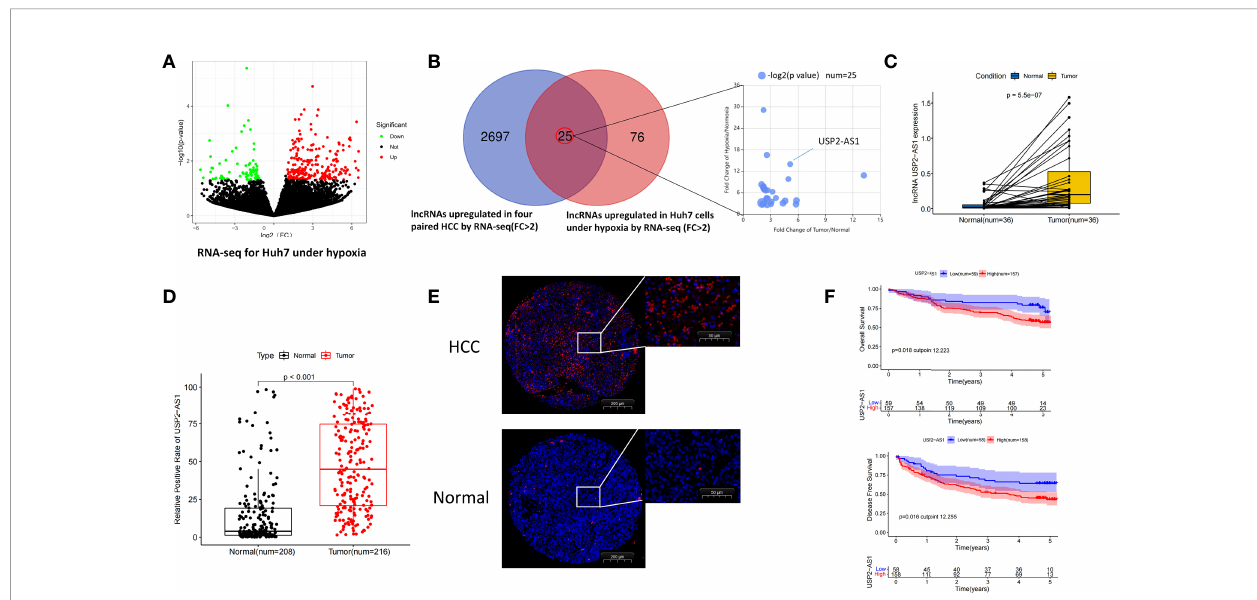
FIGURE 1 | USP2-AS1 is signi fi cantly up-regulated in hepatocellular carcinoma. (A) Molecules differentially expressed under normoxia and hypoxia in Huh7 cells identi fi ed by RNA-seq. (B) 25 intersection candidate genes obtained by hypoxia-treated Huh7 cells and HCC tissue sequencing. (C) The relative expression of USP2-AS1 in 36 pairs of HCC and adjacent non-tumor specimens by RT-qPCR. (D) Relative expression of USP2-AS1 in the HCC chips by FISH experiments, unpaired Student ’ s t-test. (E) The relative positive cell rate of USP2-AS1 in the HCC chips by FISH experiments. (F) Kaplan – Meier analysis of overall survival time and disease-free survival time in HCC patients with high USP2-AS1 expression versus low USP2-AS1